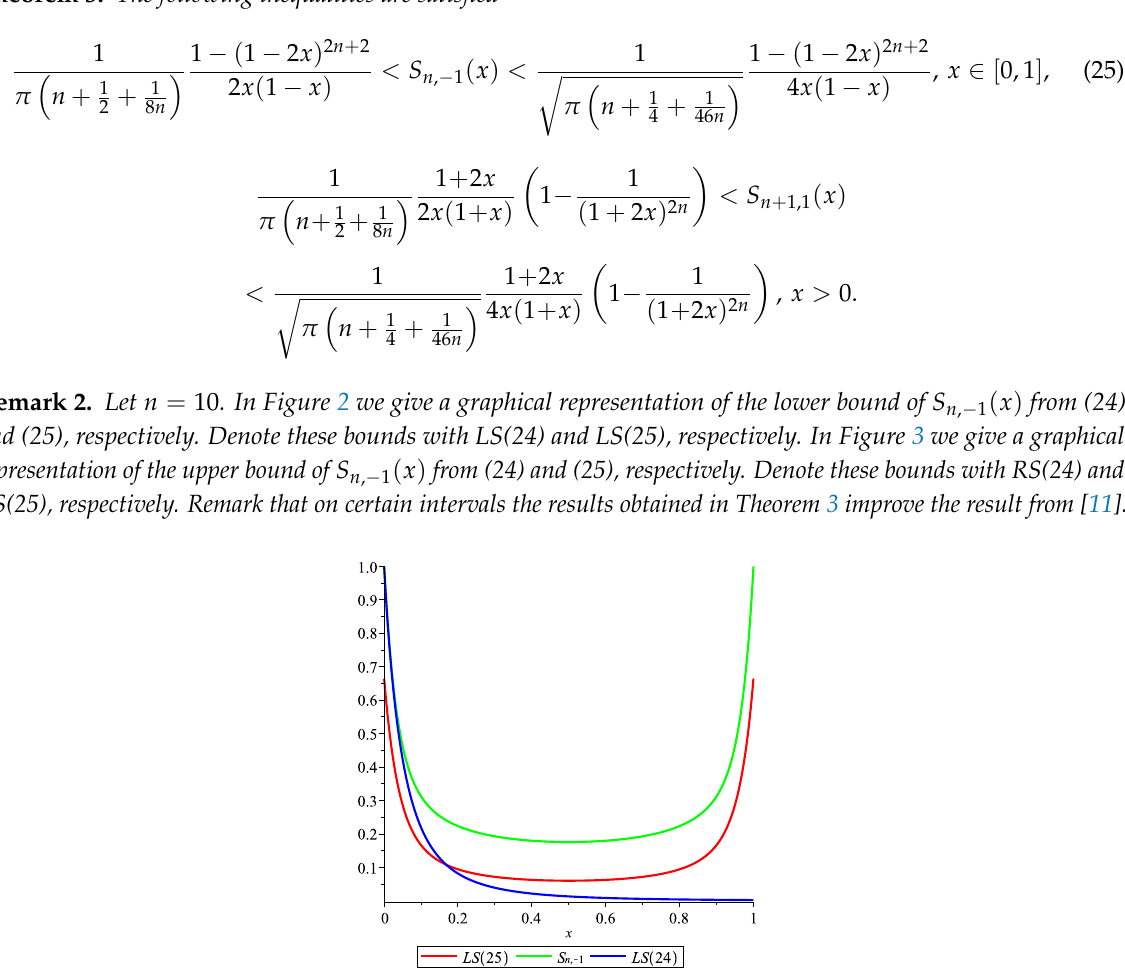
Figure 2. Graphs of lower bounds of S n , − 1